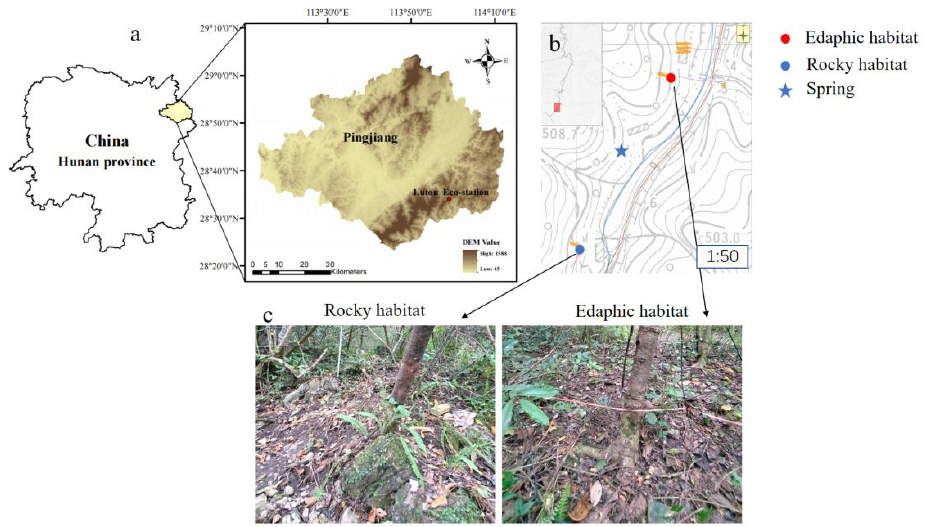
Figure 1. Map of the study and the field area. ( a ): The location of Lutou forest ecosystem observation and research Station in Hunan province; ( b ): The sampling site location in the study area; ( c ) photographs of the two habitats.